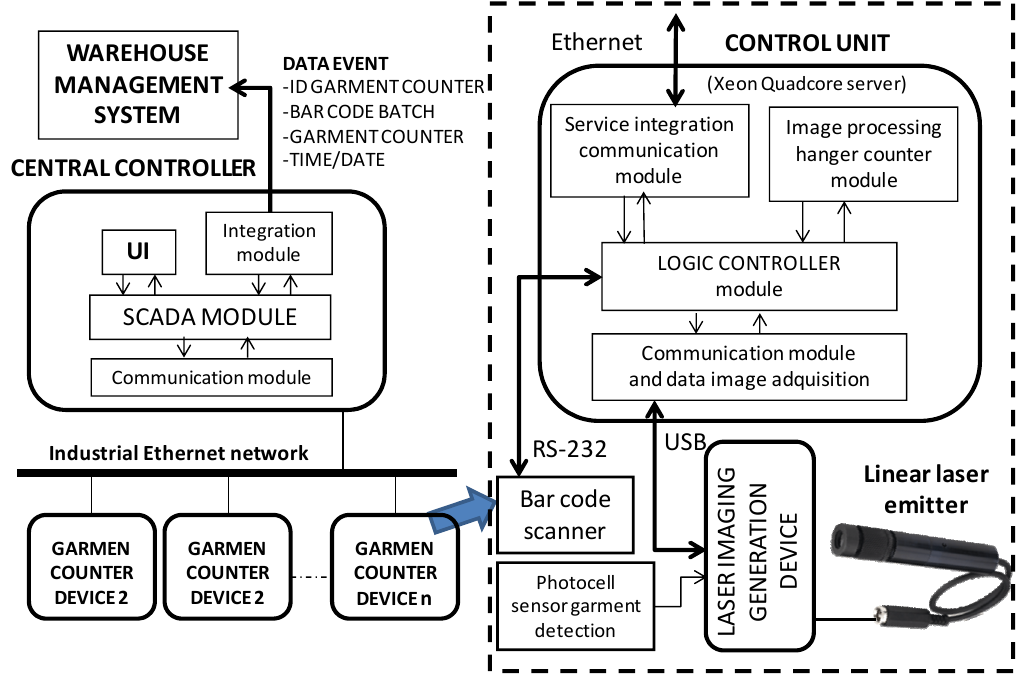
Figure 4. Central server connected to the network of garment counter devices. Integration with the warehouse management system. Functional blocks of the